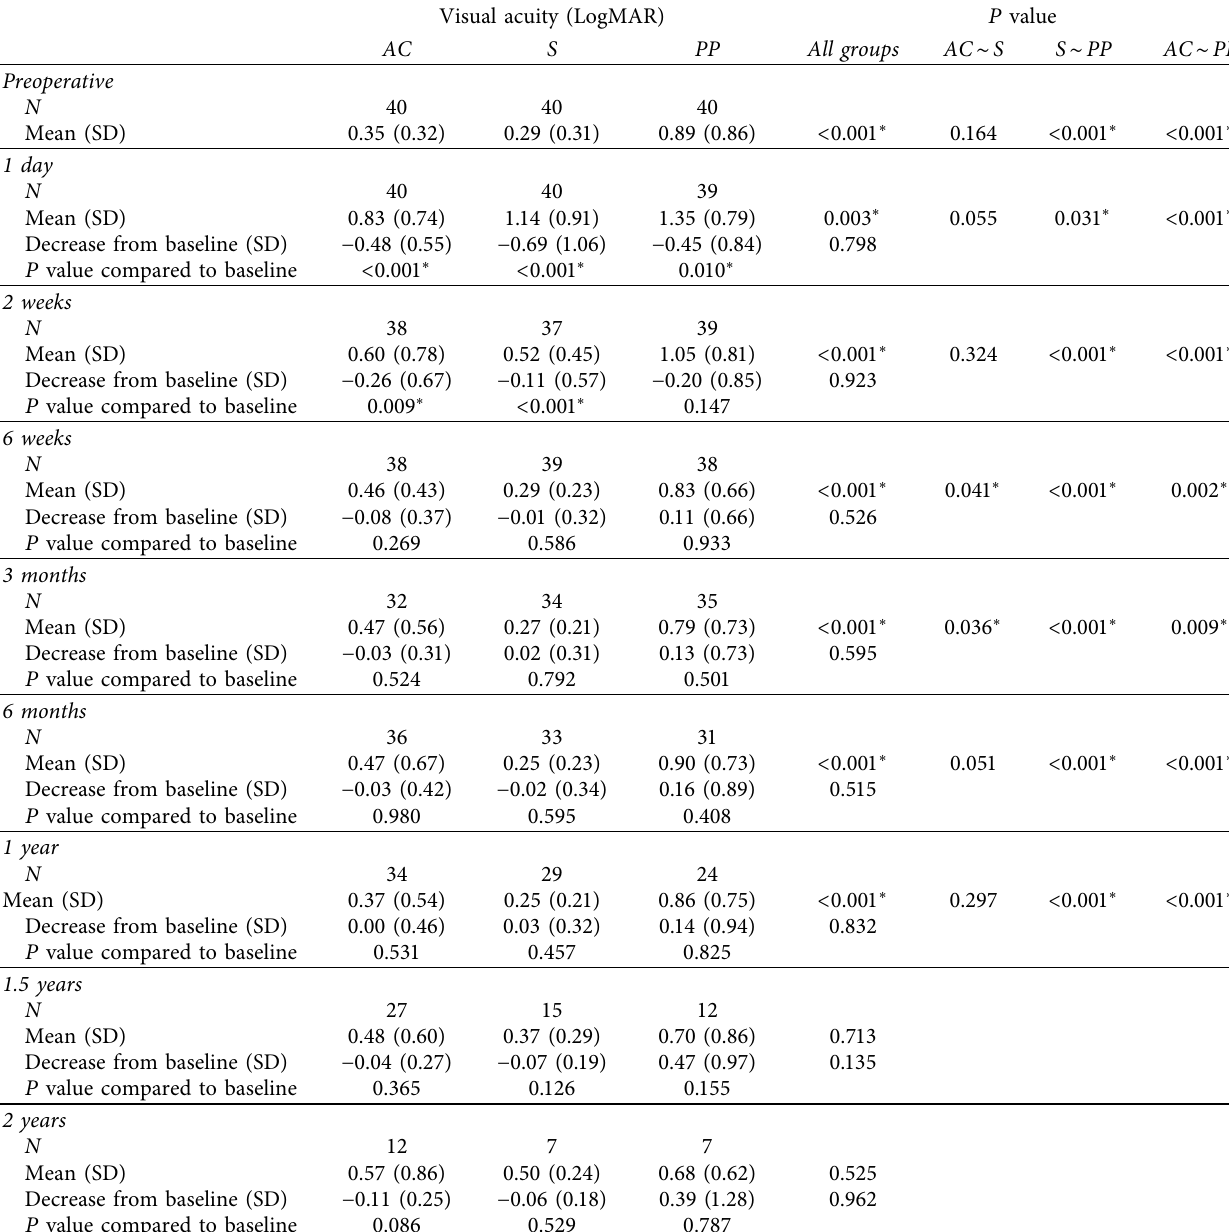
Table 5: Visual acuity outcomes data a